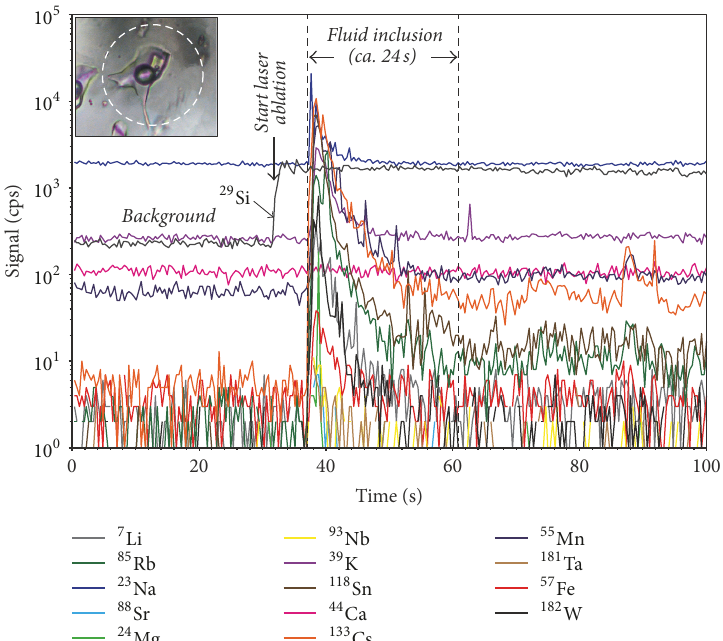
Figure 11: Typical LA-ICPMS spectrum of a primary magmatic L1-type fluid inclusion hosted in a globular quartz crystal from the Beauvoir granite (sample B1-379a; FI n ∘ A6b). The analysed fluid inclusion (picture in inset) is 17 𝜇 m in size and was ablated using a laser spot diameter of 32 𝜇 m (dashed white